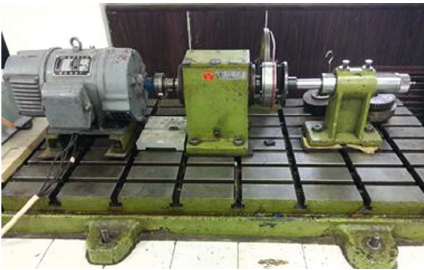
Figure 4: Test rig for rolling